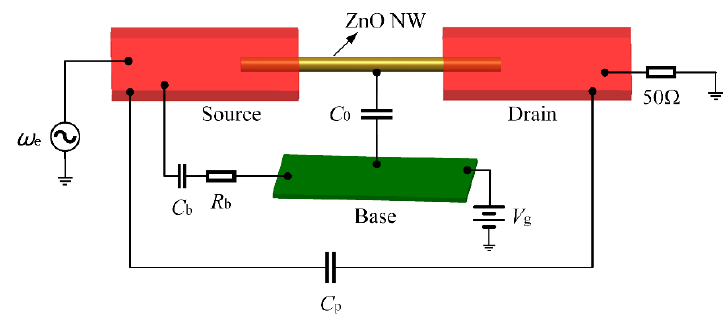
Figure 6. Schematic diagram of the parasitic parameters introduced by the test.